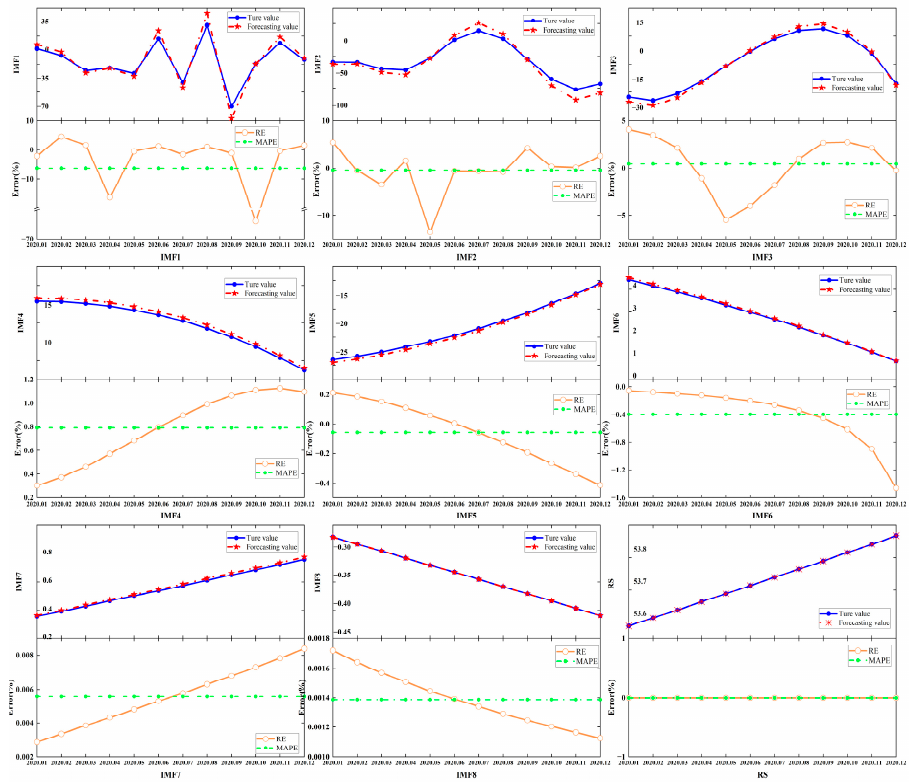
Figure 7. Prediction results of IMF1-IMF8 and trend term and the errors.